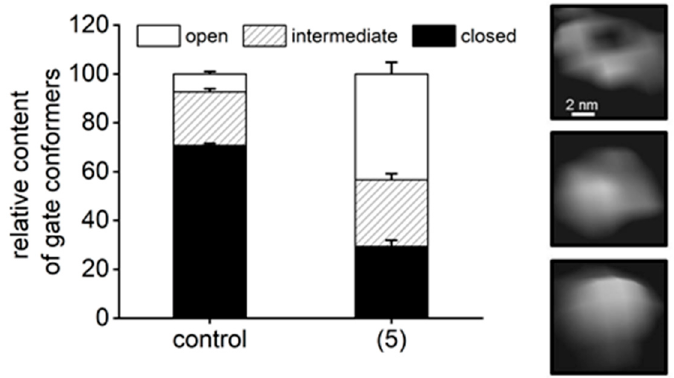
Figure 8. AFM (Atomic Force Microscopy) imaging detected a larger abundance of open-gate conformers after treatment of 20S proteasomes with (5). In control samples treated with vehicle (DMSO) the closed-gate conformation prevailed (71%), with only 7% of open-gate particles and 22% assuming intermediate conformation. The partition for latent, untreated proteasomes was undistinguishable from DMSO-treated controls (not shown and [20,39]). In the presence of 1 μ M of (5) 43% of core proteasomes assumed the open-gate conformation at any given time of AFM probing. Only 29% molecules remained in closed conformation, and 27% proteasomes were classified as intermediates. In total, 180 control and 337 (5)-treated particles/cases from n = 4 independent experiments were analyzed. Based on the results of the chi squared test, we concluded that the partition of 20S proteasome gate conformers is associated with the presence of (5) and significantly different from the partition found in the control (DMSO-treated) proteasome.